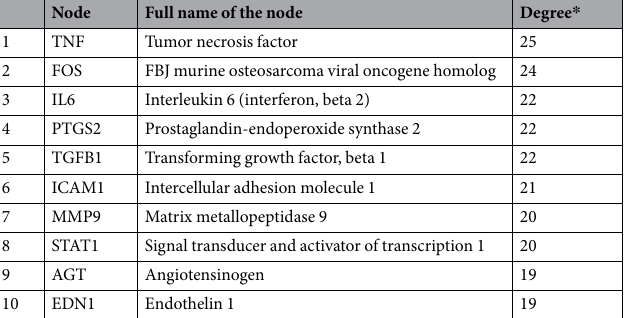
Table 2. The top 10 proteins associated with spinal cord injury (SCI) from Comparative Toxicogenomics Database (CTD), and genes associated with SCI (GAS30). * Node degree was measured for GAS30 network members.